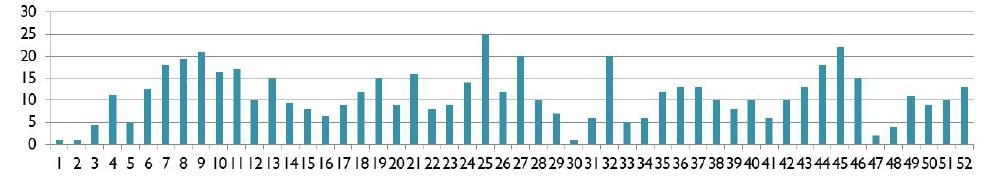
Figure 10. Number of distinct hue values per